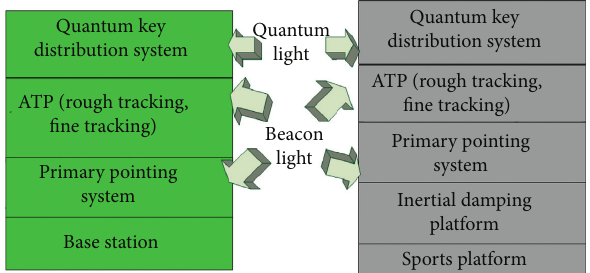
Figure 1: Three-level pointing system.